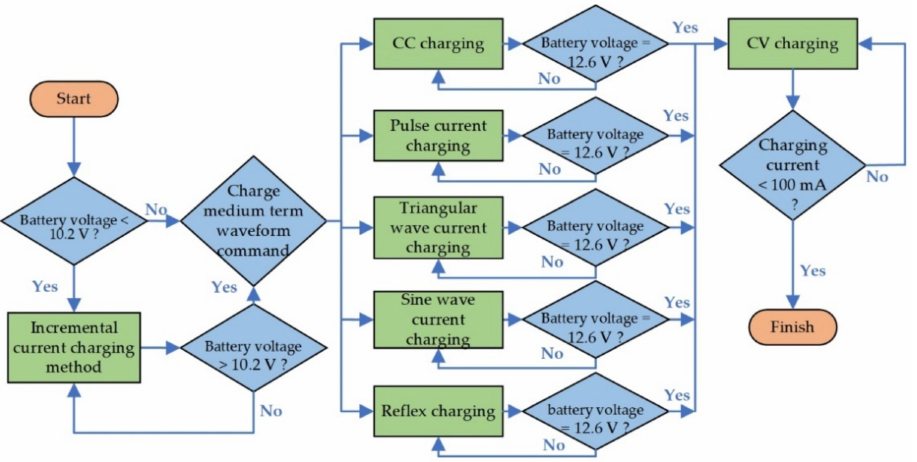
Figure 5. Flow chart of the charging